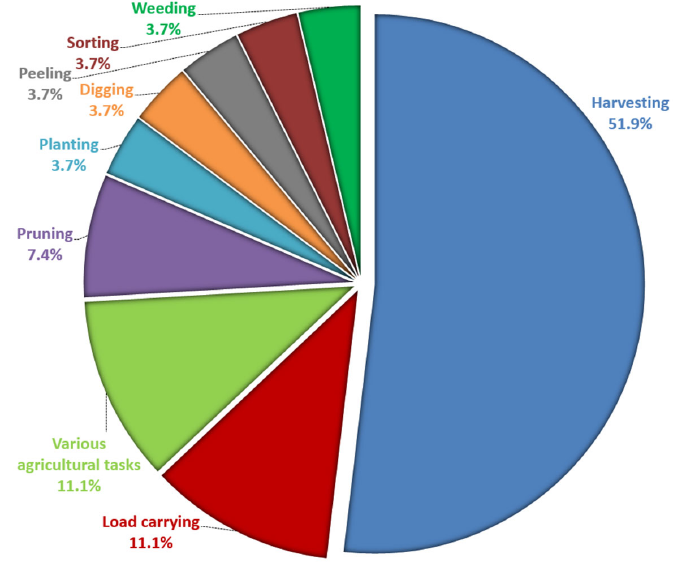
Figure 5. Distribution of the manual operations causing musculoskeletal disorders (MSDs). Table 1. List of journal papers dealing with MSDs as a result of occupation with agricultural manual operations.